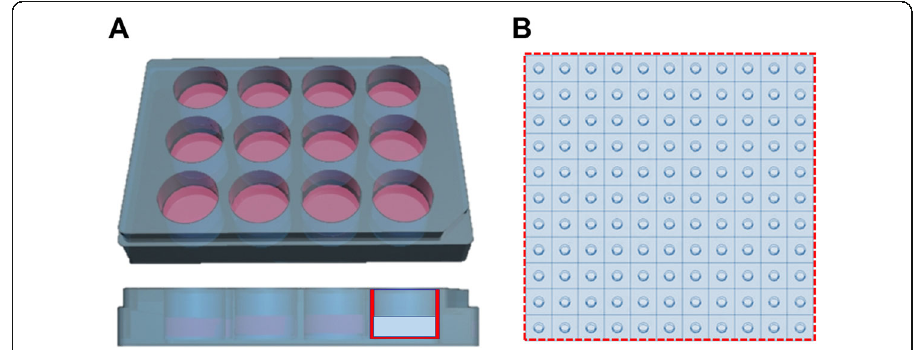
Fig. 4 Representation of the simulation environment. a Rendering of a 12 well plate with the simulated cylindrical geometry superimposed on the side view. b Section of the bottom of the cylindrical well with the reference cell sample (4 h set-up) lying on